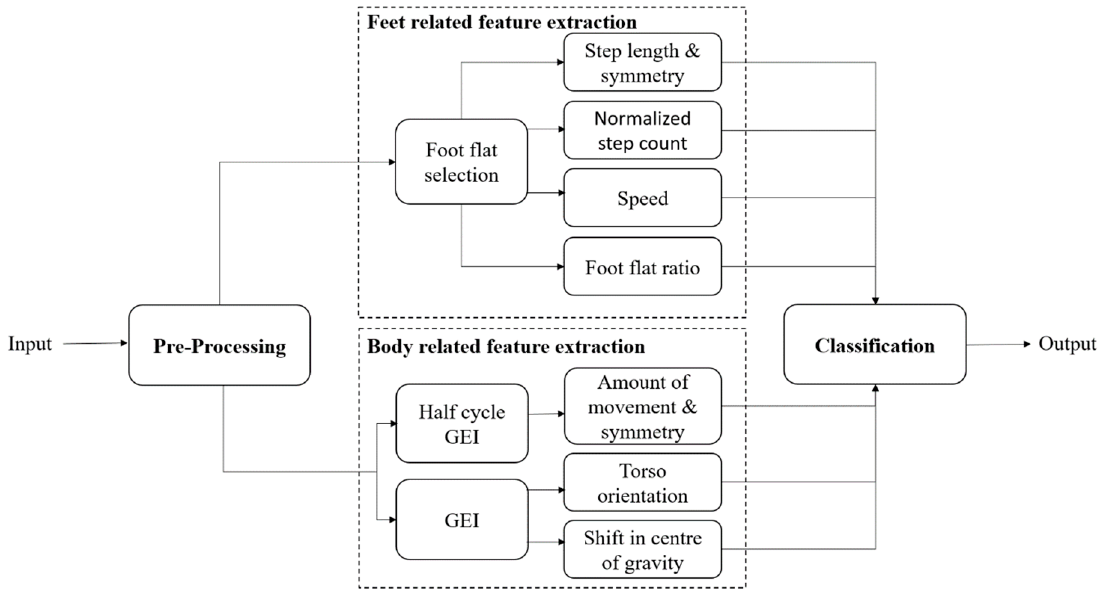
Figure 1. Proposed system architecture.